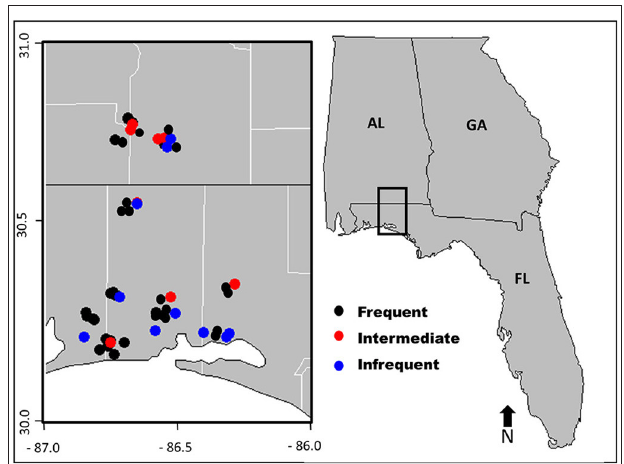
FIGURE 2 | Reference map of Southeastern United States with study area highlighted in black rectangle. Within the study area, individual plot locations are indicated by colored dots corresponding to each of the three fire return